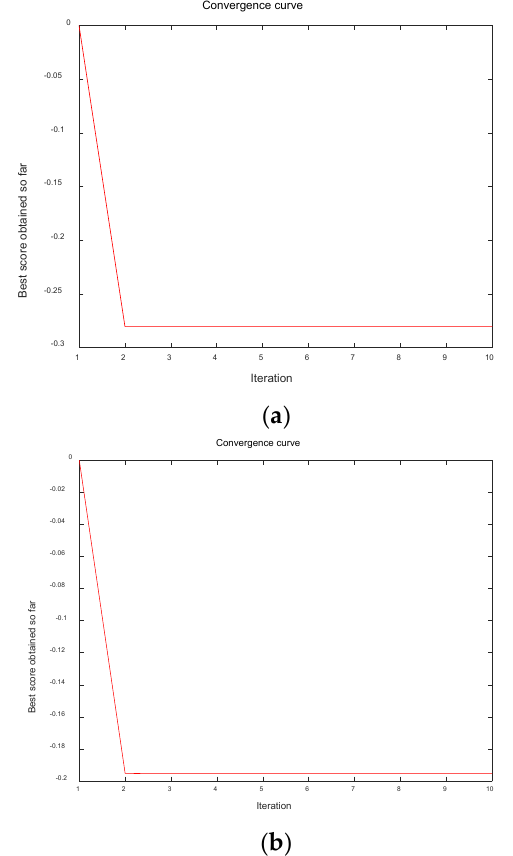
Figure 5. Convergence of the objective function of the station retrieval data: ( a ) for the BRST station, the convergence of the objective function; ( b ) for the HKQT station, the convergence of the objective function.